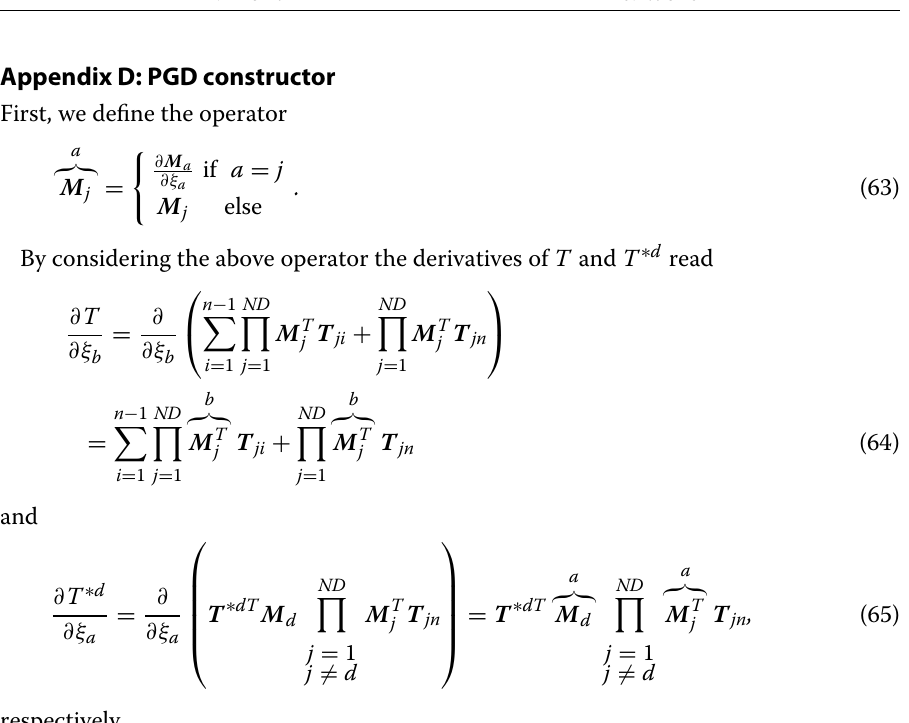
Table1 Maximum error in the separated approximate representation of coordinates x and y # modes Maximum error in x representation Maximum error in y representation 1 1.572e-01 7.656e-01